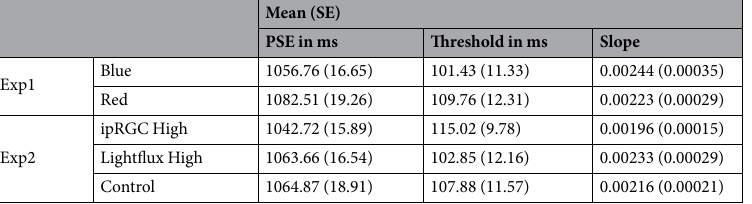
Table 2. Results of Experiment 1 and